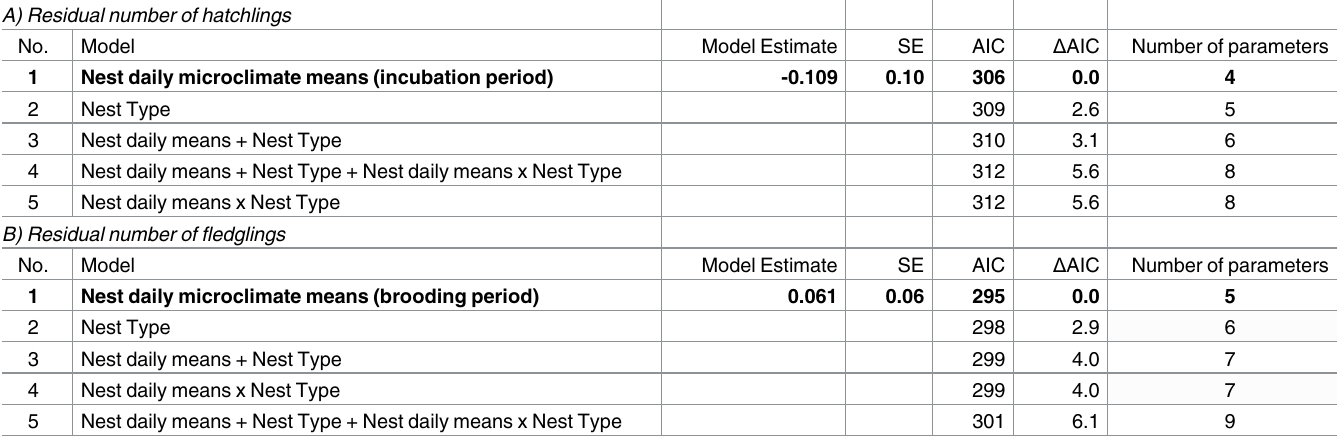
Table 2. GLMMs testing for the effect of potential predictors on the season-adjusted number of A) hatchlings and B) fledglings. Nest temperatures were recorded duringA) incubation or B) broodingstages in 90 and 84 kestrel nests, respectively. Nest temperatures were corrected for the influenceof ambi- ent temperatures and definedas nest microclimate. Models with Δ AIC < 2 were selectedas best models and shown in bold.